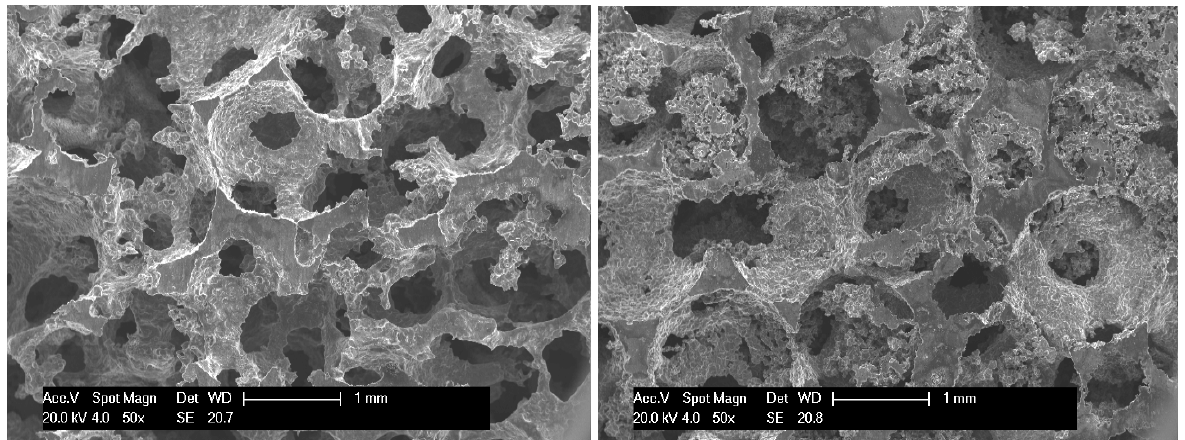
Figure 11. SEM images of foams made by infiltration of salt bead preforms compacted at 39 MPa, (left) at 14 psi and (right) at 36 psi.